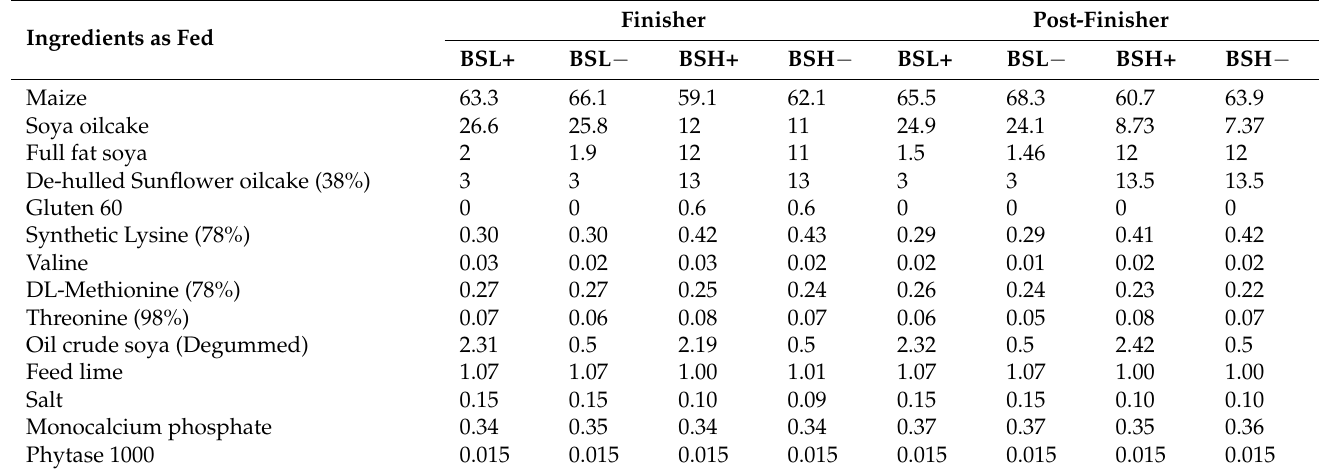
Table 2. Composition and calculated nutrients (%) of the basal diets for the finisher (20–28 d) and post-finisher phase (29–35